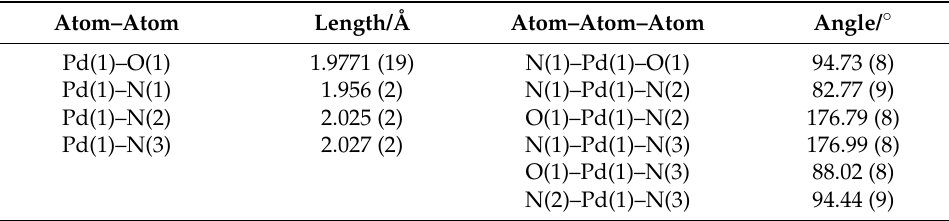
Table 2. Selected bond parameters for 1 (cid:48) .